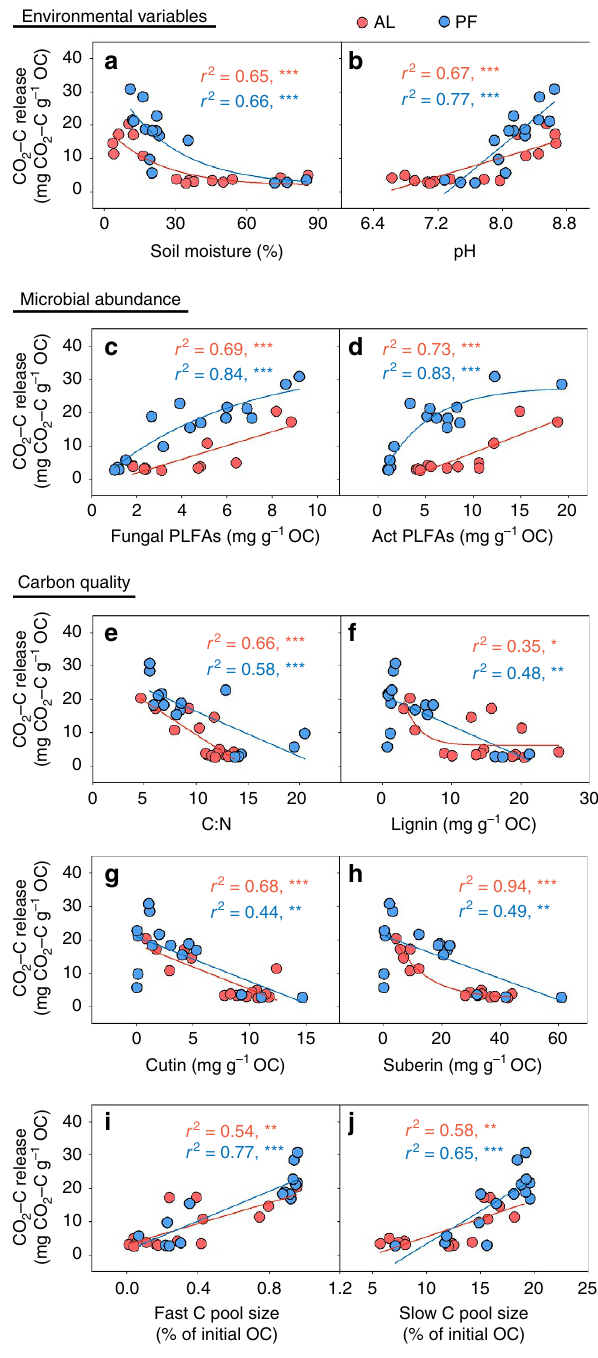
Figure 3 | Relationship between CO 2 –C release and several controlling variables. CO 2 –C relationships with environmental factors, including ( a ) soil moisture and ( b ) pH, microbial abundance, including ( c ) fungal PLFAs and ( d ) actinomycic PLFAs, and carbon quality, including ( e ) C:N, ( f ) lignin- derived compounds, ( g ) cutin-derived compounds, ( h ) suberin-derived compounds ( i ) fast C pool size and ( j ) slow C pool size. CO 2 –C release was normalized to SOC to represent the apparent SOC decomposability. Red solid circles represent data points in the active layer ( n ¼ 15) and blue solid circles represent data points in permafrost deposits ( n ¼ 15). Act PLFAs: actinomycete PLFAs. r 2 , proportion of variance explained. *, ** and *** indicate significant correlation between CO 2 –C release and the corresponding variable at P o 0.05, P o 0.01, P o 0.001,